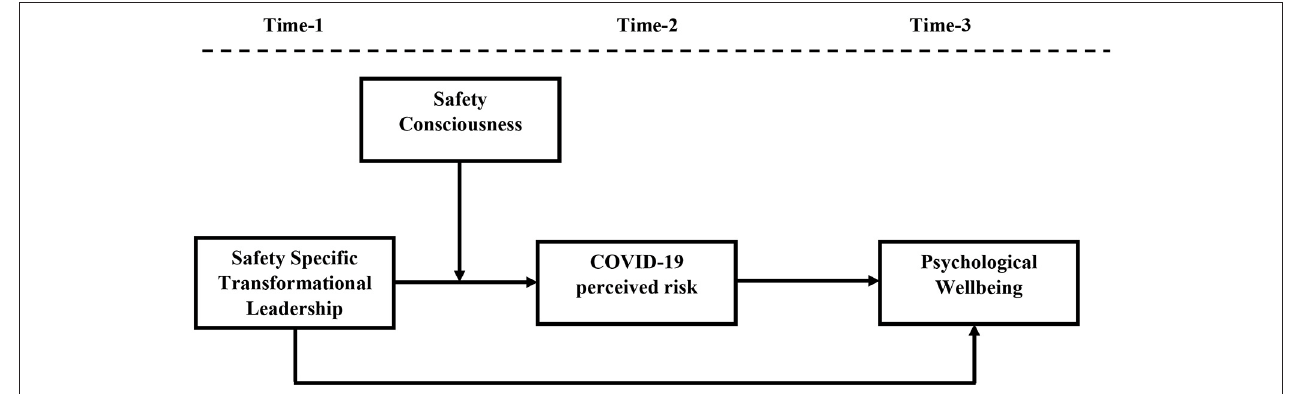
FIGURE 1 | Research model. Shows proposed model where safety specific transformational leadership enhances psychological well-being of employees by reducing COVID-19 perceived risk at different levels of safety consciousness.